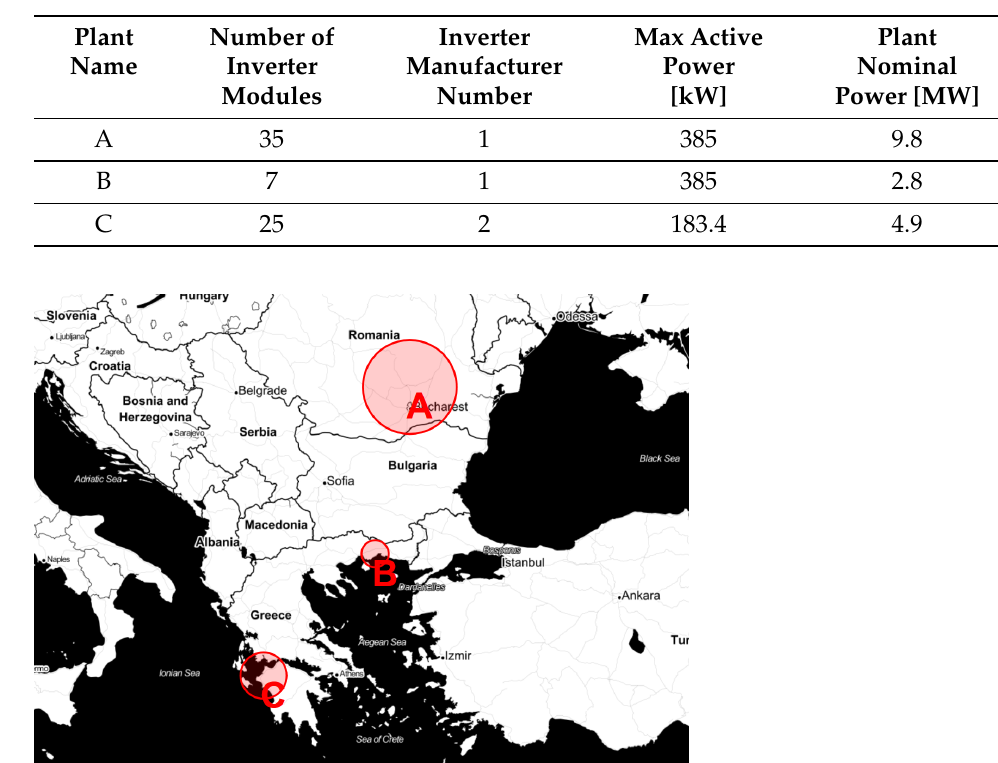
Table 1. List of considered PV plants: plant A is located in Romania, whereas plants B and C in Greece.